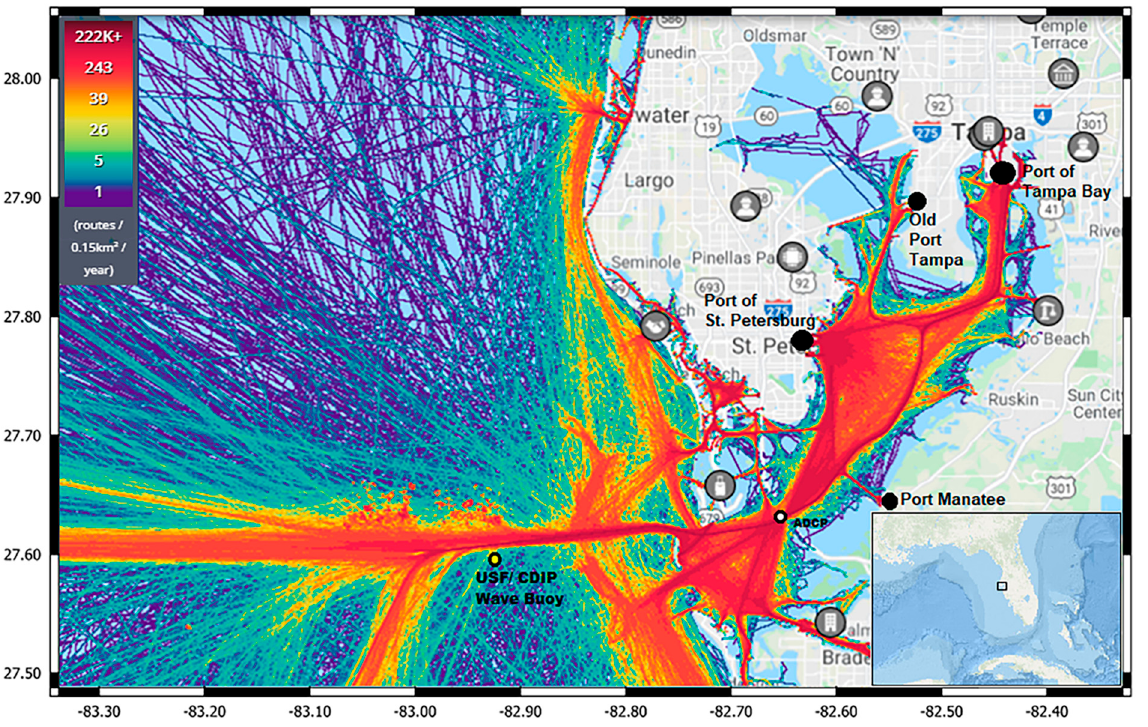
Figure 1. Vessel tracks to and from Tampa Bay, compiled from AIS data for the entire year of 2019. The yellow circle marks the USF/CDIP Datawell Waverider buoy location at the entrance of the Tampa Bay navigation channel. The white circle marks the closest Acoustic Doppler Current Profiler (ADCP) to this location. The active Tampa Bay ports are marked with black circles. Source: Marine Traffic 2019 Density Map, modified by author.